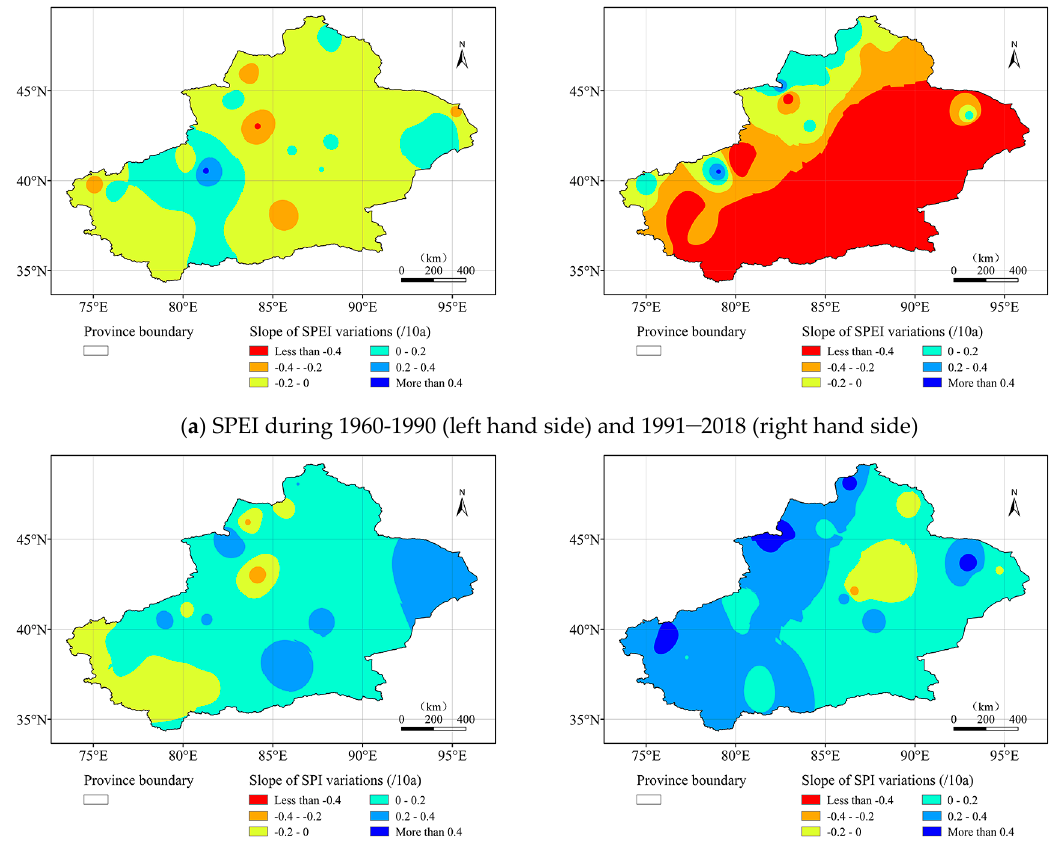
Figure 11. The spatial changes of the annual SPEI ( a ) and the annual SPI ( b ) during 1960–1990 and 1991–2018. and